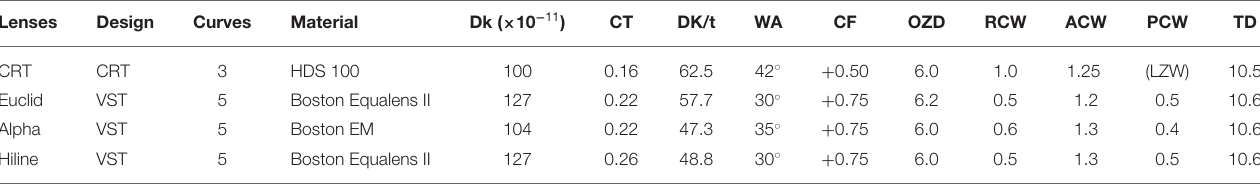
TABLE 1 | Characteristics and standard parameters of four different orthokeratology (OK) lenses.